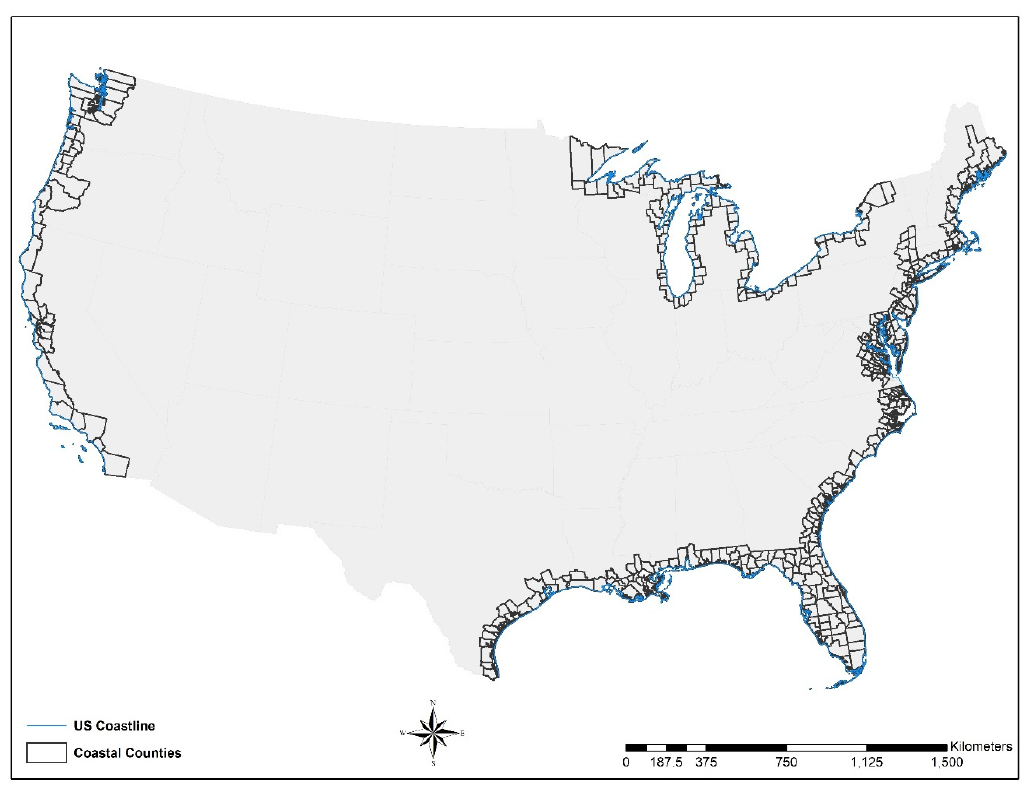
Figure 1. Map of the study area.